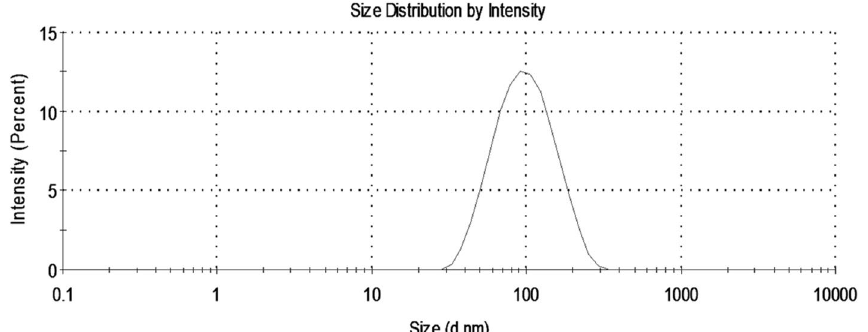
Figure 5. Size distribution of green synthesized AgNPs by DLS.